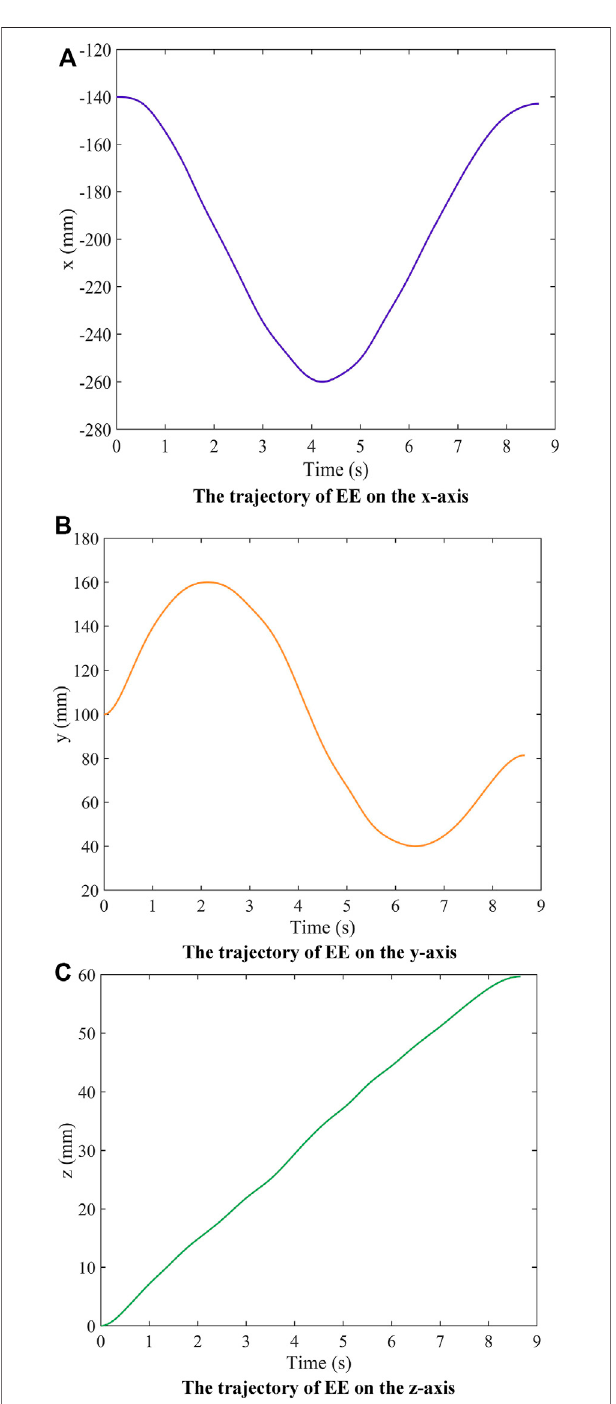
FIGURE 10 | The trajectory of EE on the three axes of